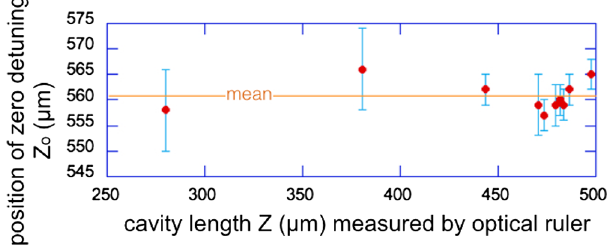
FIG. 7. Series of measurements of the position of zero detuning of cavity